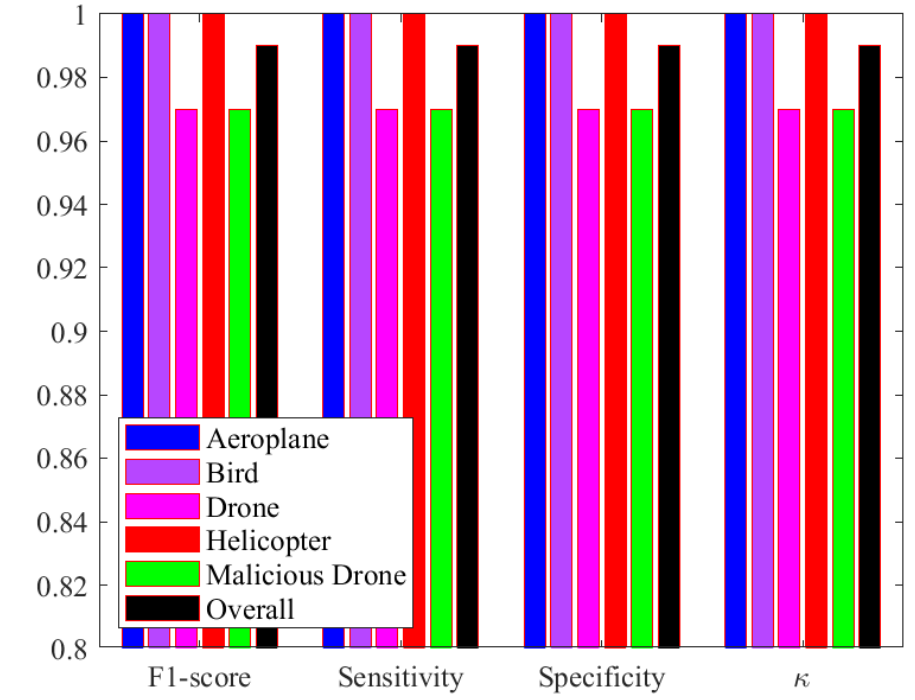
Figure 6. The classification performance metrics for different individual class and overall classes of the ViT classifier.